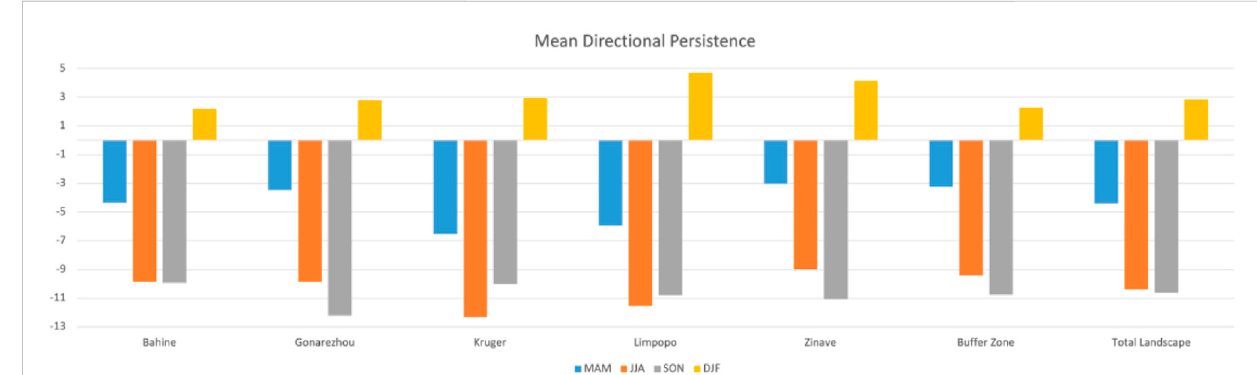
FIGURE 7 Mean Directional Persistence (D) by national park and season (MAM, March, April, May; JJA, June, July, August; SON, September, October, November; DJF, December, January, February) from 2000 to 2020 (2000 – 2004 baseline and 2005 – 2020 comparison to benchmark).